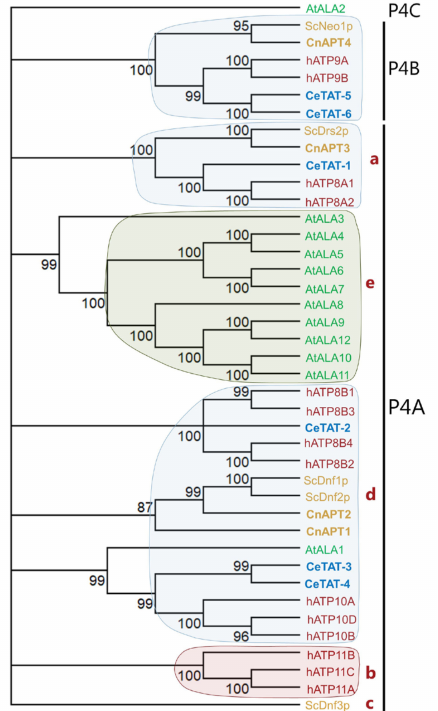
Figure 1. Apt1p belongs to the P4A-ATPase clade. Phylogenetic tree of sequences representing all annotated P4-ATPases from C. neoformans , H. sapiens , the model plant A. thaliana , the yeast S. cerevisiae , and the worm C. elegans . The phylogenetic tree was inferred from maximum likelihood analysis with 1000 bootstrap iterations performed using Mega X. Node values represent maximum likelihood statistical values with a maximum of 100%. All nodes with statistical values less than 80% were collapsed into multifurcations. In the phylogenetic tree, proteins from humans are written in red, those from plants in green, those from worm in blue, and those from yeast in gold letters. Proteins belonging to the same clade are shadowed: red, human-specific clade; green: plant-specific clade; gold: fungi-specific clade; light blue, clades containing proteins from organisms belonging to several life kingdoms. Shadowing and subclade division within the P4A clade (letters a–e) are as described in [49]. For accession numbers, see Materials and